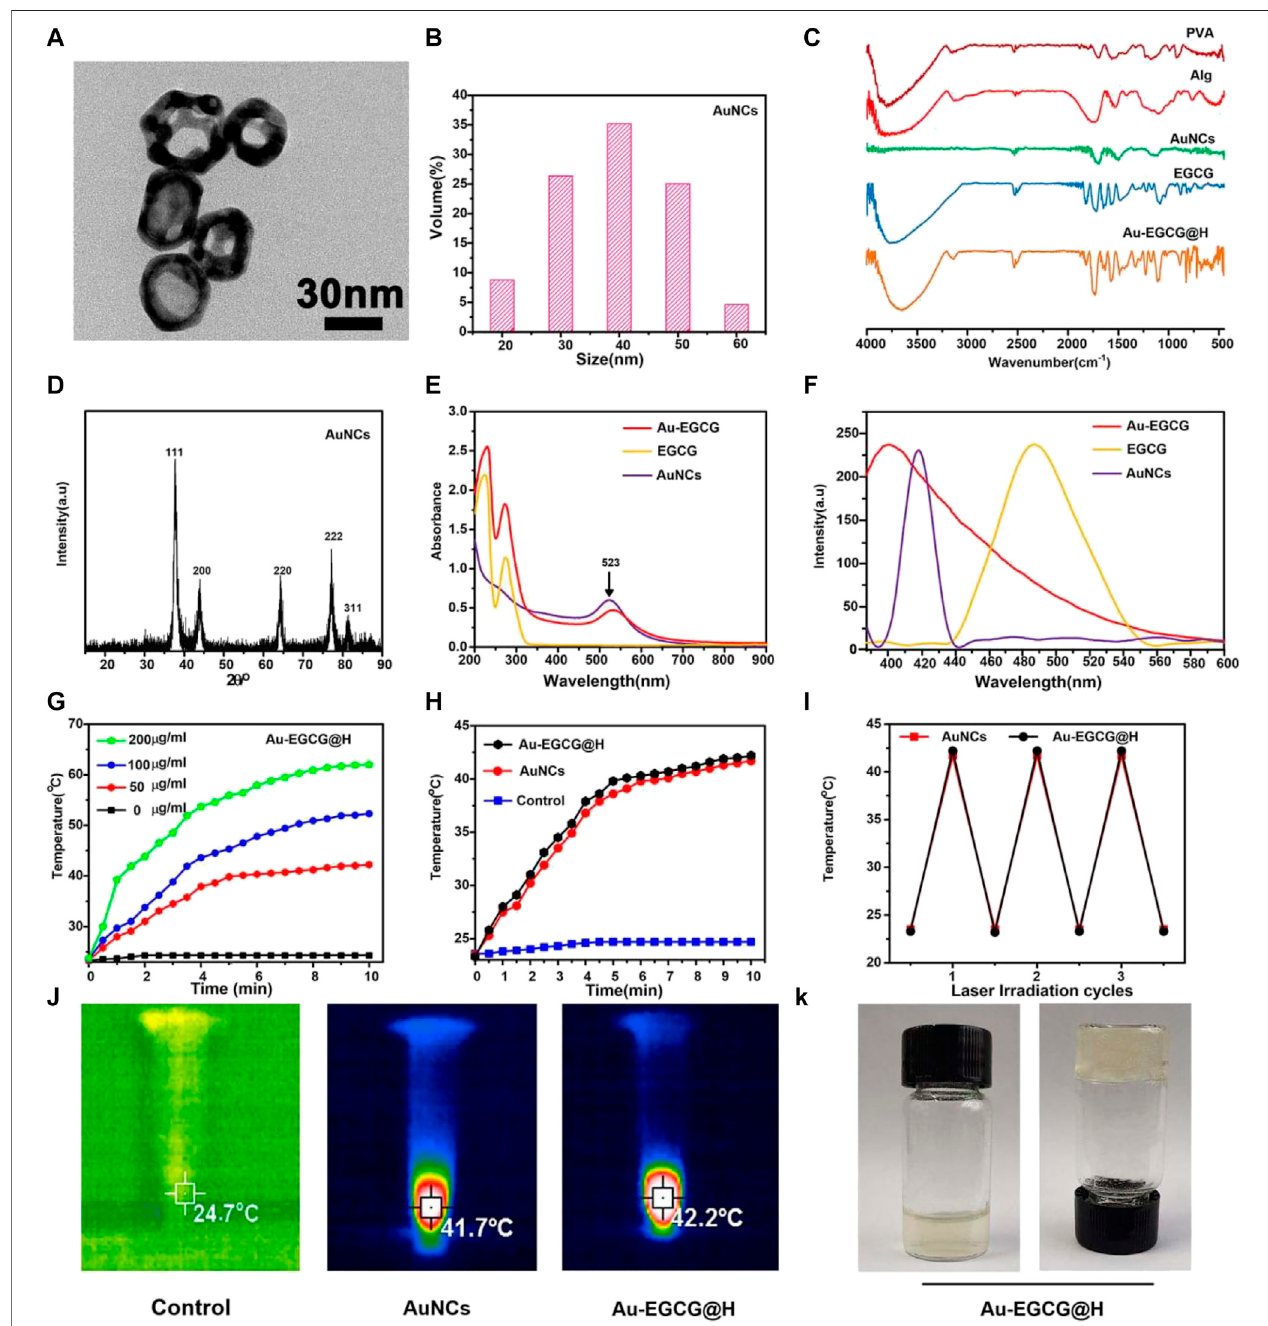
FIGURE 1 | TEM images (A) ; DLS size distribution of AuNCs (B) ; Fourier Transform Infra-Red spectra (C) ; the patterns of XRD (D) ; Ultraviolet-visible (E) ; Steady- state fl uorescence spectra of the samples (F) ; Heating curves of Au-EGCG@H at various concentrations (G) ; Heating curves of Au-EGCG@H, AuNCs, and water (H)